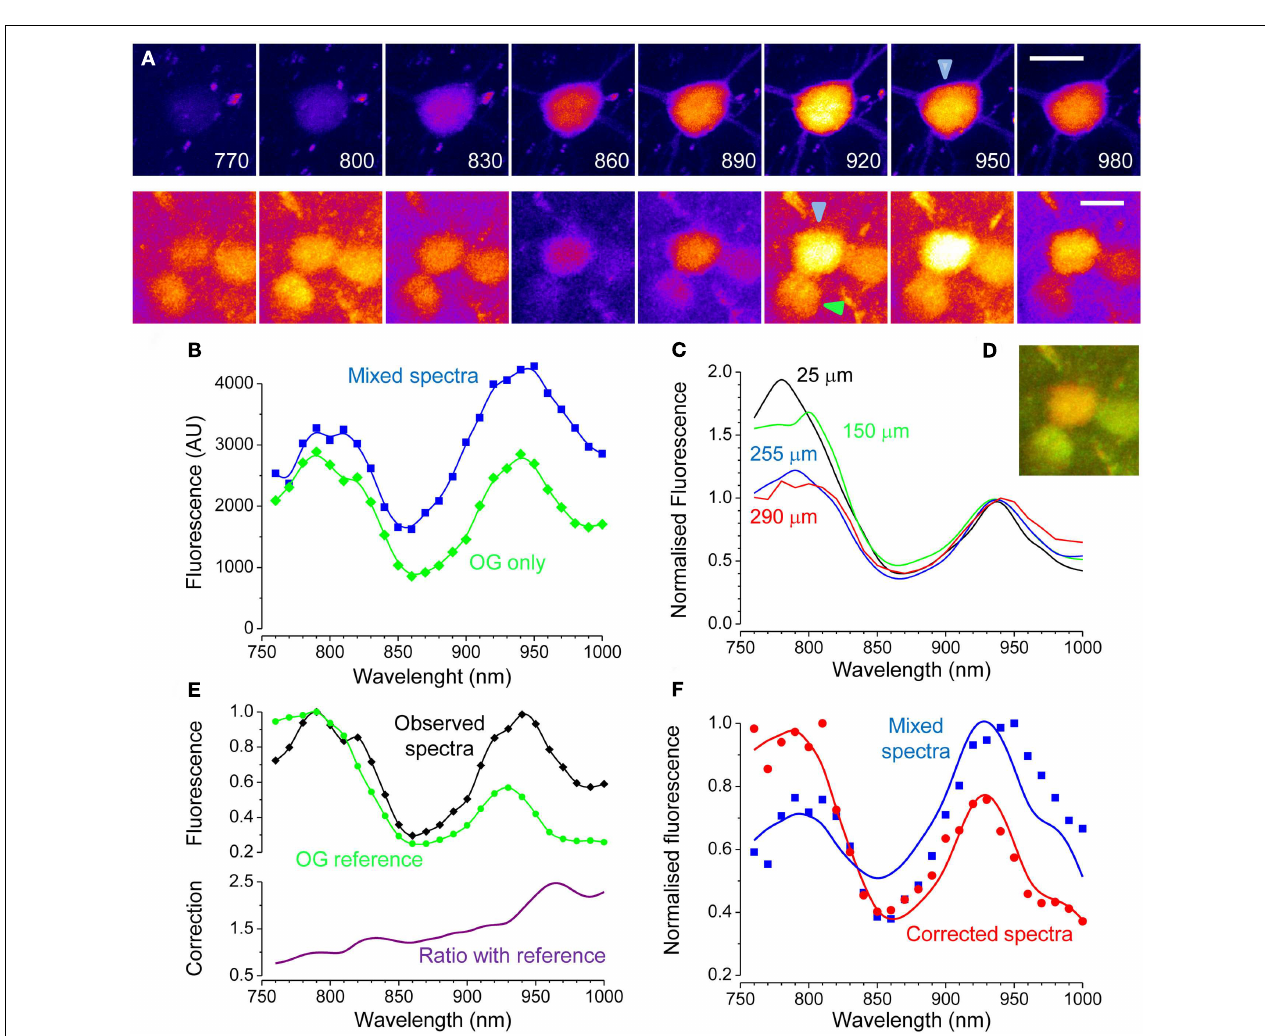
and 920 excitation.The expression of EGFP is deduced by the orange-red color of the cell body. (E) Comparison of the OG spectra (black) recorded from one neuron (green arrowhead in panel (A) with the reference spectra (green).The observed spectra is obviously distorted, with a strong loss of fluorescence at shorter excitation wavelengths.The lower panel shows this effect by plotting the ratio between the distorted spectra and the reference spectra. (F) The ratio with the reference spectra has been used to correct the spectra from the EGFP cell loaded with OG (original data: blue symbols, corrected data: green symbols).The original spectra cannot be fitted properly by the linear decomposition ( α = 0.53; β = 0.71; blue line), that, in contrast, is very accurate after correction ( α = 0.92; β = 0.26; red